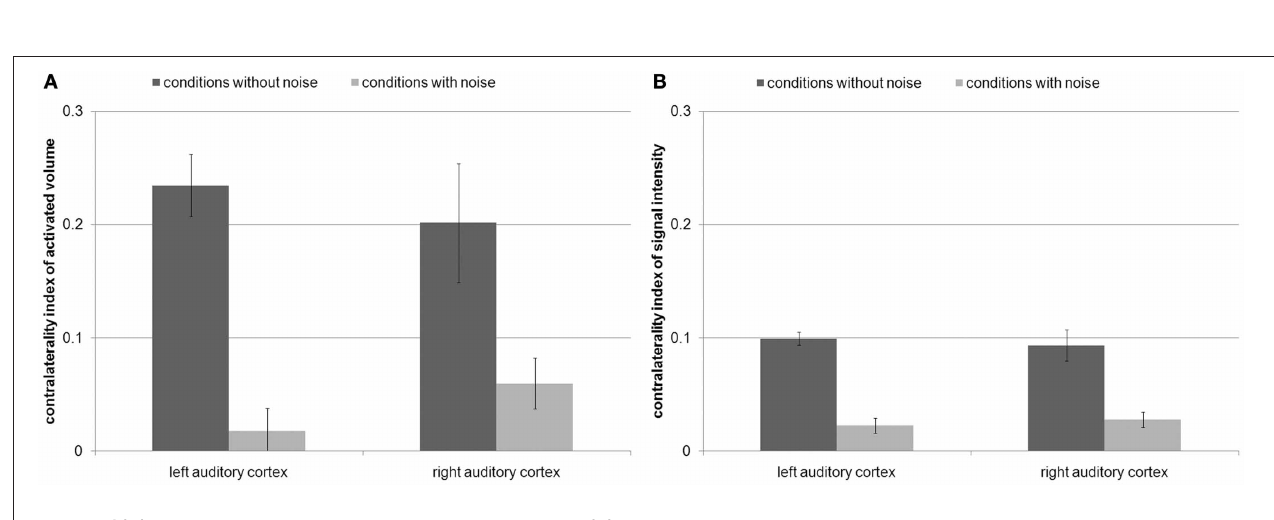
ipsilateral FM tones. Values around zero indicate a balanced amount of activity by contralateral and ipsilateral FM tones. The contralaterality index of both activated volume and signal intensity decreased from the conditions without noise to the conditions with noise in both auditory